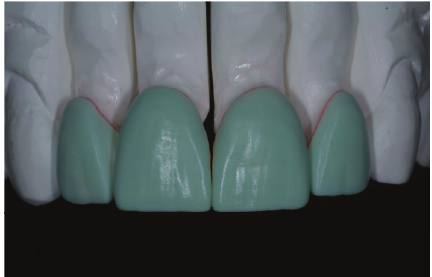
Figure 12: Wax-up for definitive restorations.